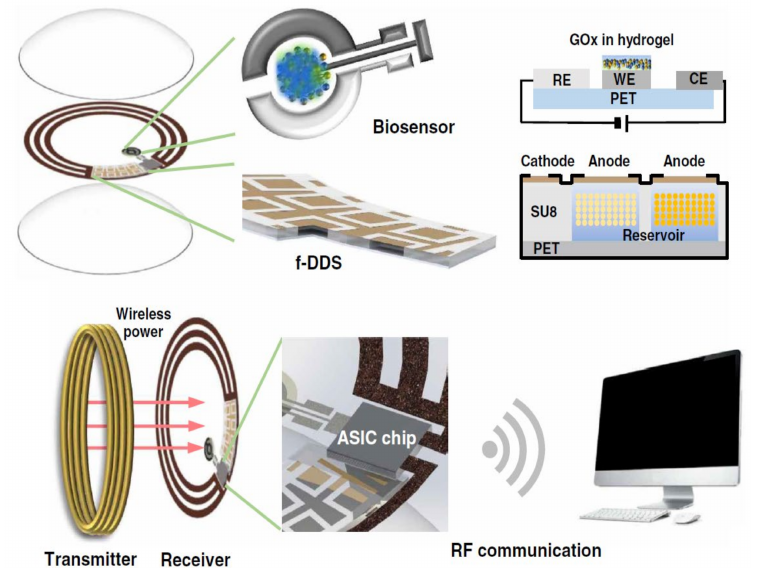
Figure 2. Remotely controllable smart contact lens designed for noninvasive glucose measure- ment and controlled drug release targeting diabetic retinopathy. Reprinted with permission from Mehta et al. (2020). Copyright 2020 American Association for the Advancement of Science, Science